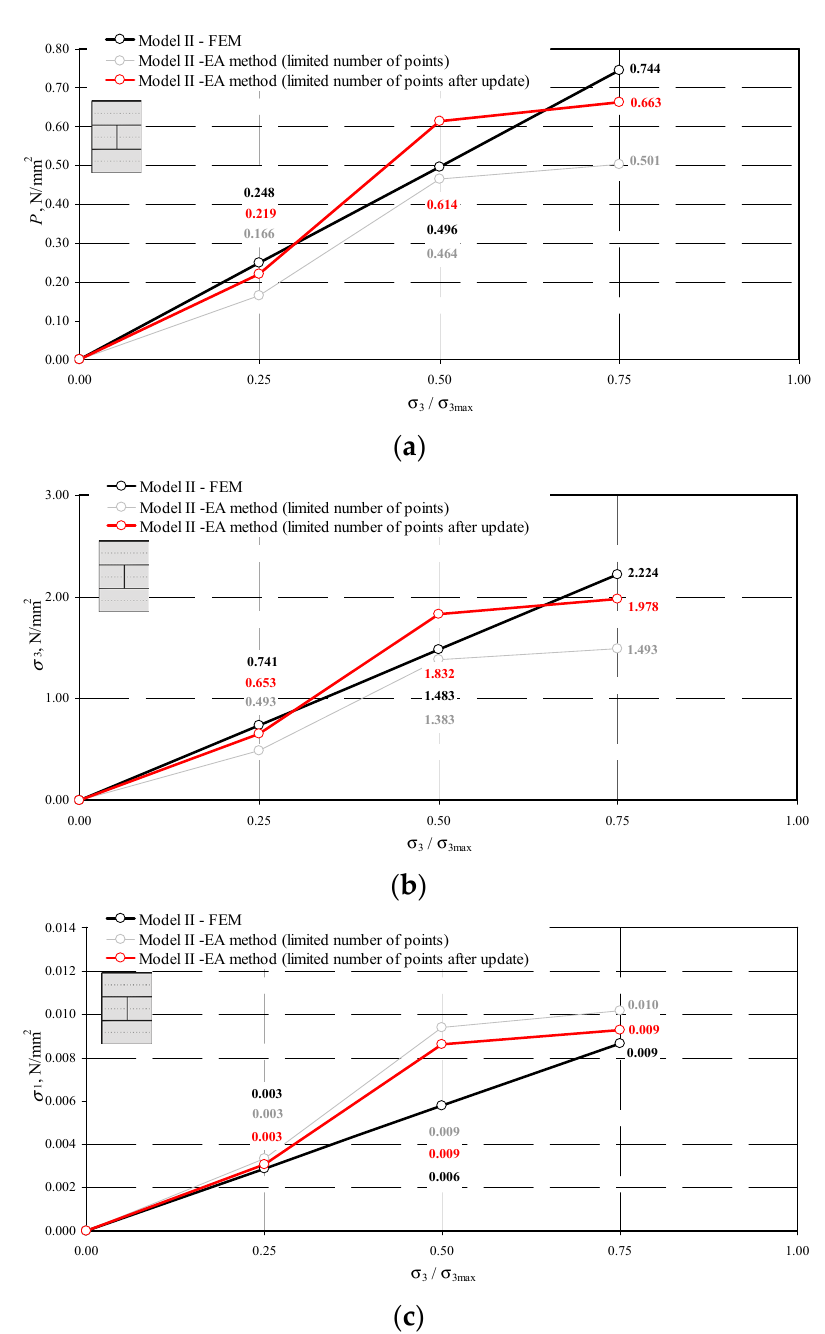
Figure 20. Comparison of stress values determined by the NDT and FEM methods for the model I-1: ( a ) mean hydrostatic stress; ( b ) normal stress perpendicular to the plane of bed joints; ( c ) nor- mal stress parallel to the plane of bed joints.